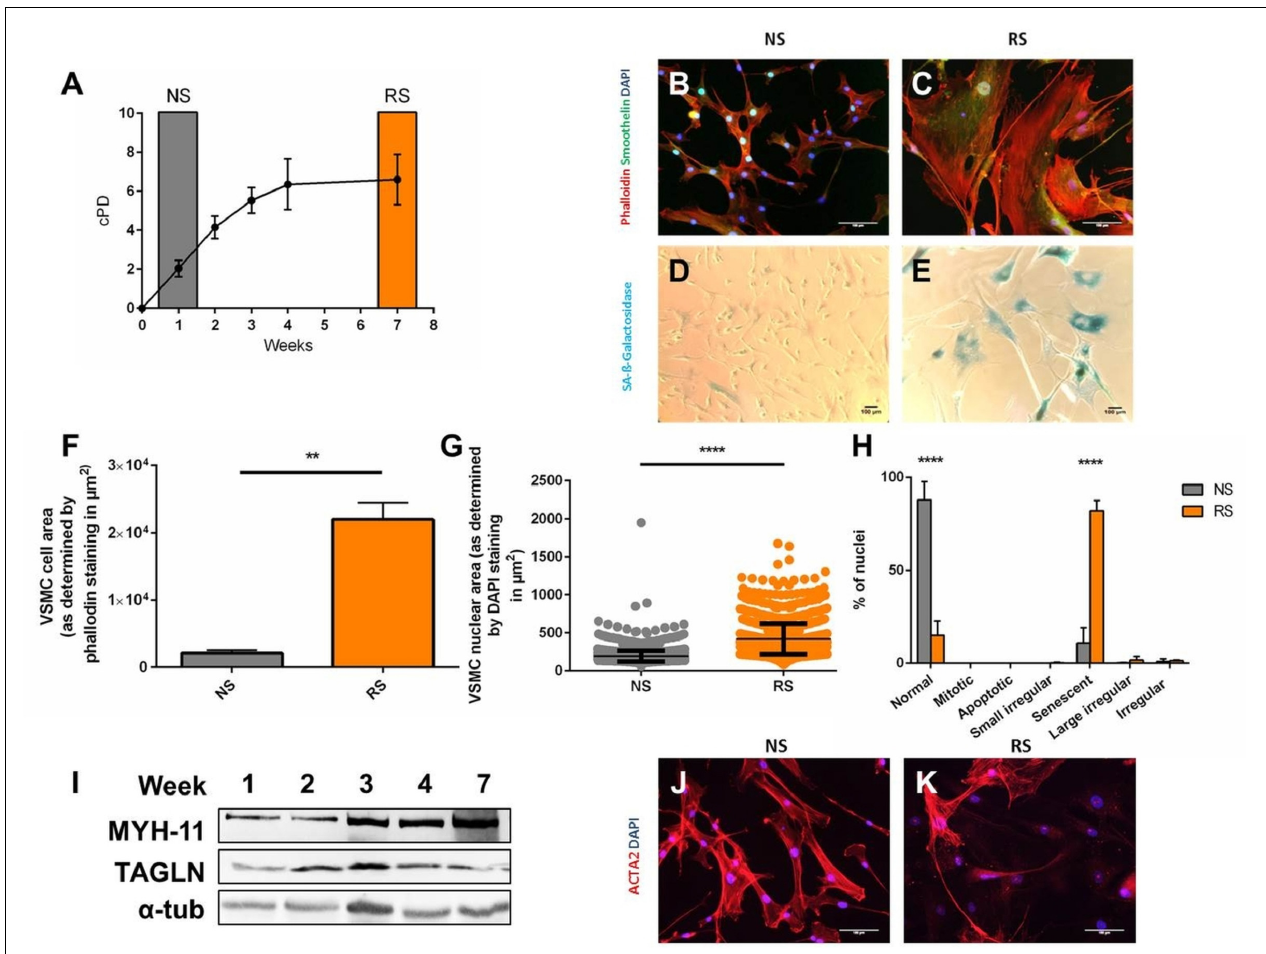
FIGURE 1 | Induction and morphological markers of replicative senescence. Cells were stained DAPI, phalloidin, smoothelin, and α -smooth muscle actin (ACTA2) enabling measurement of cell nuclear size in Image J and characterization. Western blot was per (A) Cumulative population doublings (cPD) of serially passaged VSMCs ( n = 3). (B,C) Immunofluorescence microscopy of RS VSMCs, on 20 × magnification. (D,E) Bright field microscopy of SA- β -galactosidase staining, on 10 × magnification. (F) Cell size comparison between NS and RS VSMCs, n = 3, t -test. (G) Nuclear size comparison between NS and RS VSMCs, n = 3, t -test. (H) Nuclear morphology categorization via NMA; two-way ANOVA with multiple testing corrections, n = 3. (I) Western blots of Myosin-11 (MYH-11), Transgelin (TAGLN) and α -tubulin ( α -tub) of a passaging timeline in RS. (J,K) Immunofluorescence microscopy of ACTA2 in NS and RS VSMCs, on 20 × magnification. ** p < 0.01, **** p <